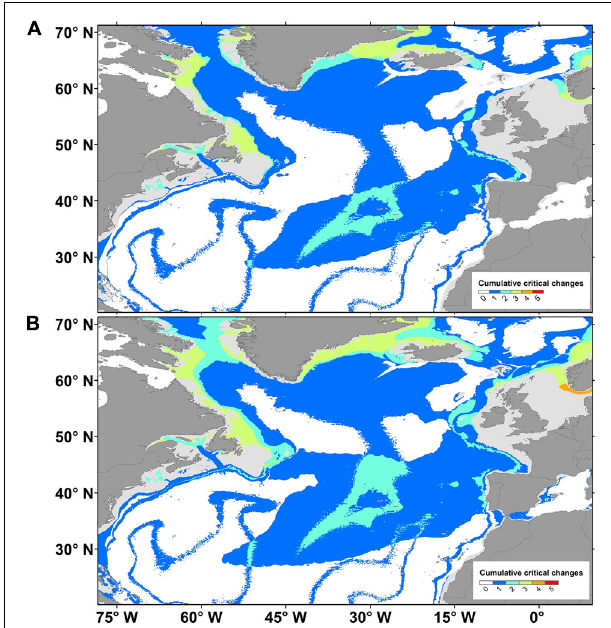
FIGURE 5 | Predicted cumulative critical changes in seafloor conditions in the North Atlantic Ocean by 2100. Critical conditions include temperature increase of (A) > 1 ◦ C or (B) > 2 ◦ ; particulate organic carbon (POC) flux reduction of (A) > 40% or (B) > 50%; pH reduction > 0.3 and aragonite and calcite saturation levels < 1. Dissolved oxygen will not likely achieve hypoxic conditions values < 1.5 ml · l - 1 in 2100 so it was not